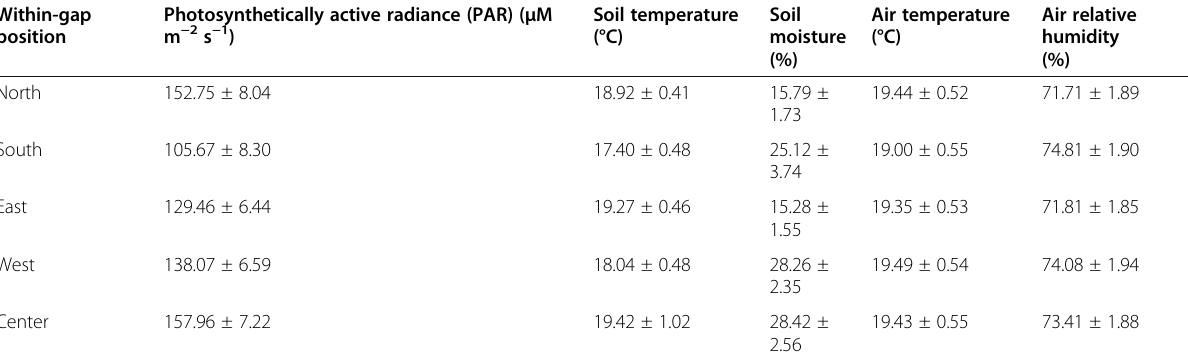
Table 2 Mean (± S.E.) values of environmental factors at five within-gap positions during two growing seasons Within-gap